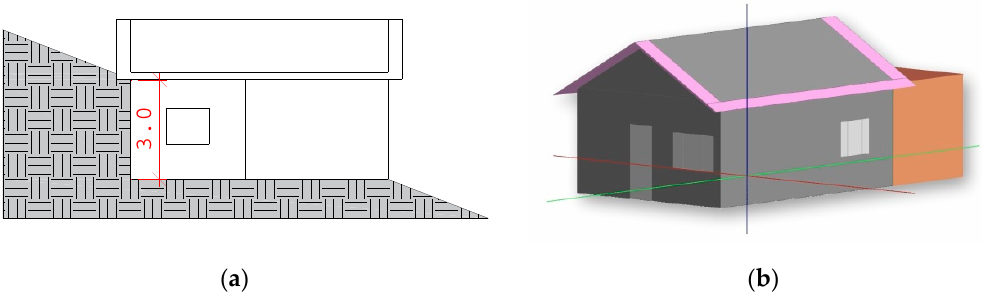
Figure 3. ( a ) Schematic section and ( b ) modeled bermed earth-sheltered wall located in the